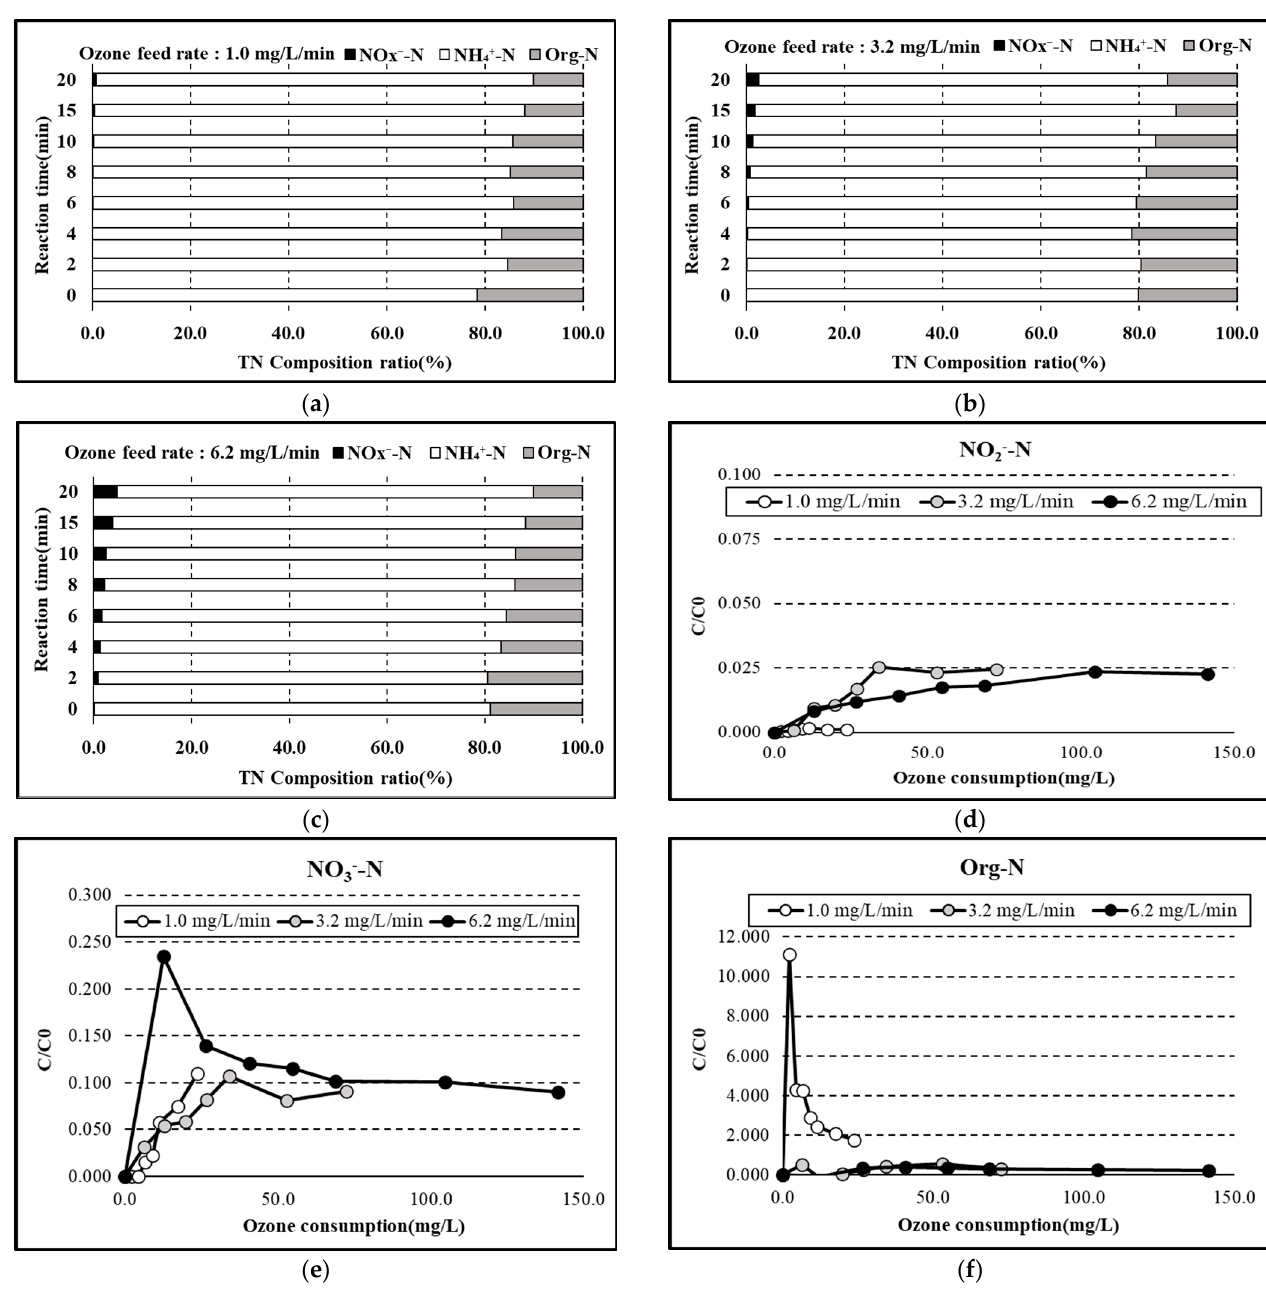
Figure 4. Effect of ozone feed rates on ( a ) NO 2 − -N, ( b ) NO 3 − N, and ( c ) Org-N, and ozone consump- tion vs. generated ( d ) NO 2 − -N, ( e ) NO 3 − N, and ( f )